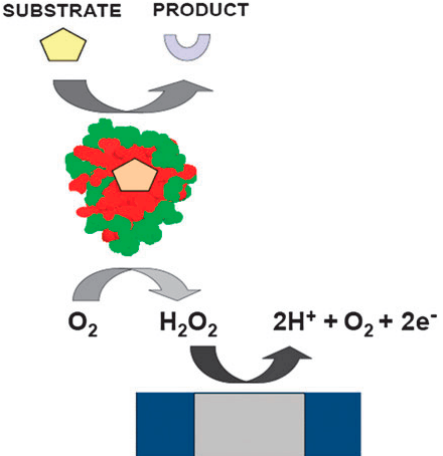
Figure 2. First-generation biosensor that depends ambient oxygen with amperometric detection [2] Copyright 2010. Reproduced with permission from The Royal Society of Chemistry.